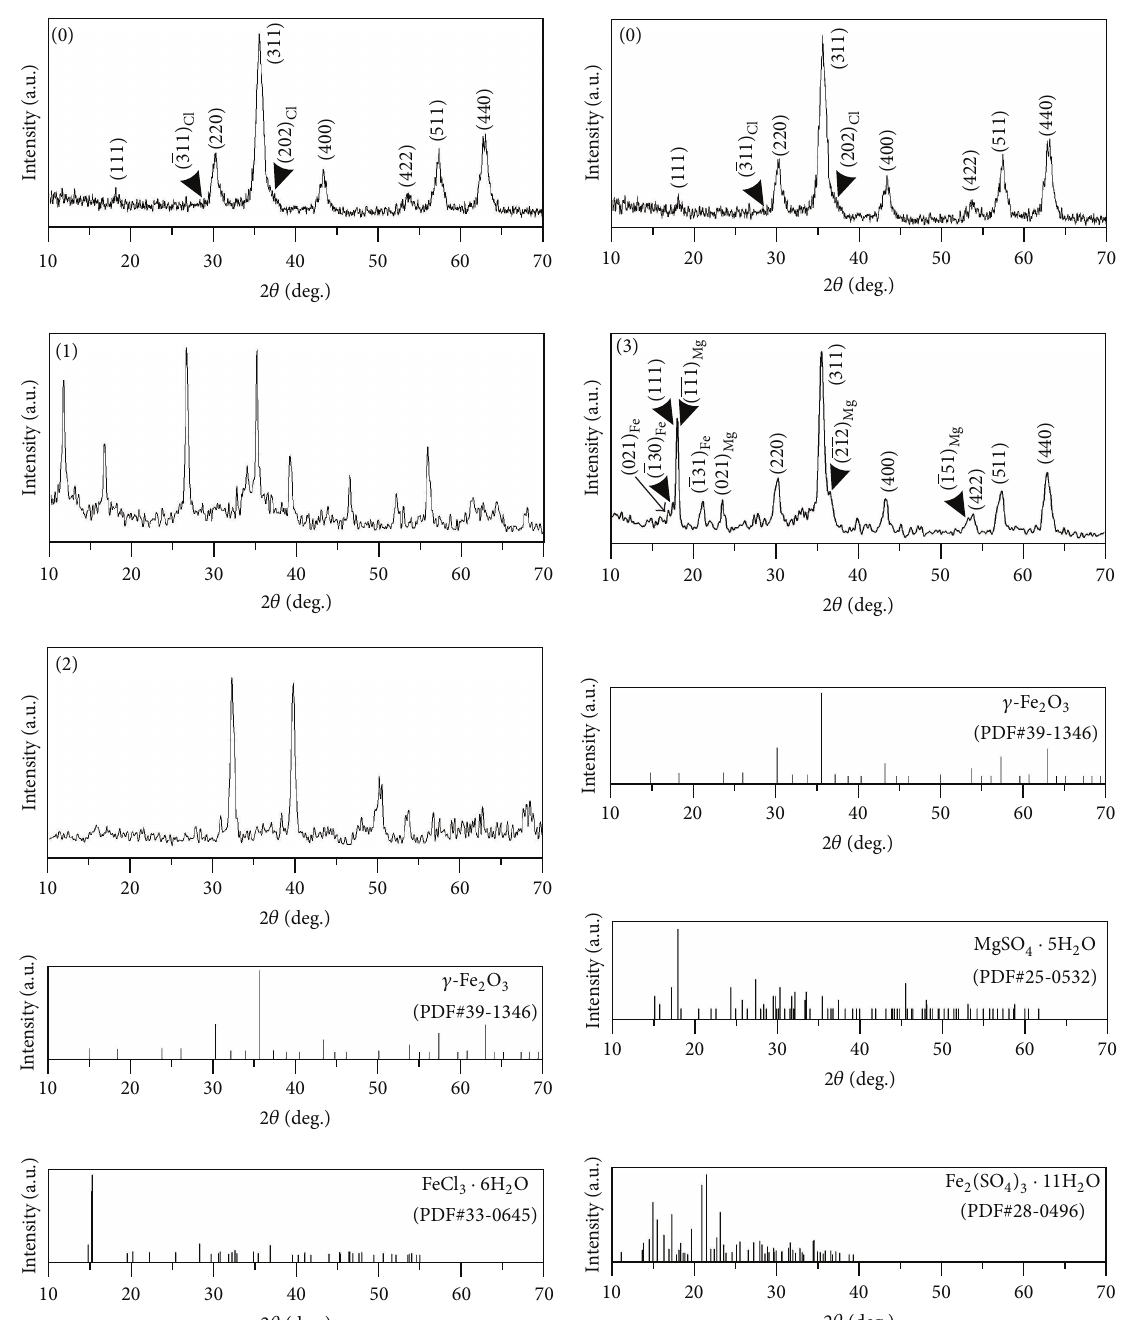
Figure 1: XRD patterns of all samples, with (hkl), ( hkl ) Fe 2 (SO 4 ) 3 ⋅ 11H 2 O,